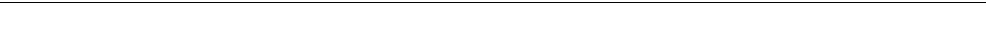
Table 1. Farm and Sociodemographic Characteristics of a Sample of 40 Tennessee Farmers